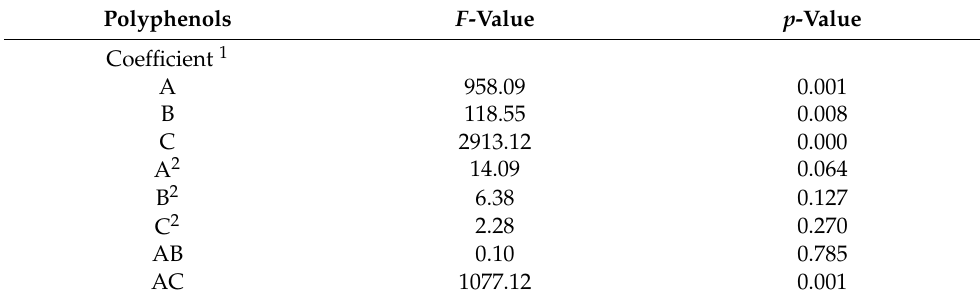
Table 2. p -value and F -value for model